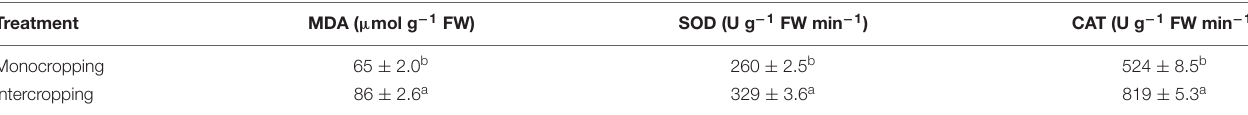
TABLE 6 | The MDA and activity of antioxidant enzymes in intercropping and monocropping at noon.